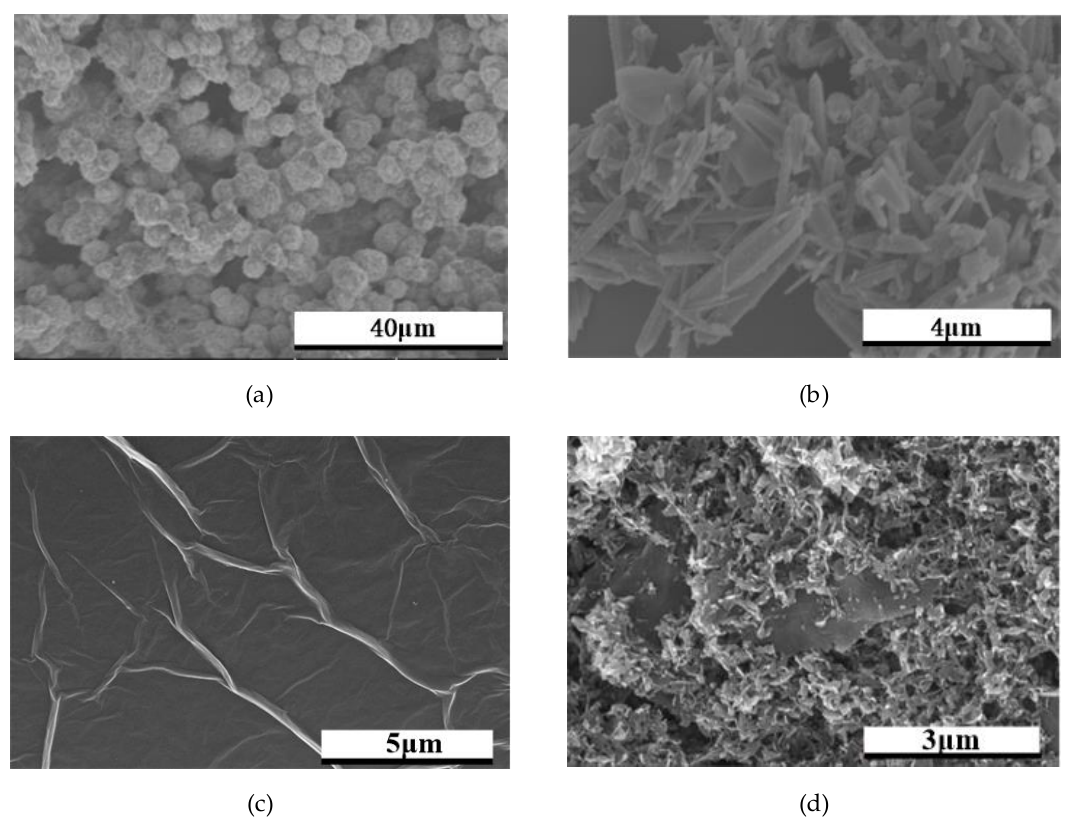
Figure 2. SEM image spectra for ZnO and ZnO composite graphene: ( a ) ZnO microspheres; ( b ) ZnO nanorods; ( c ) ZnO nanosheets; ( d ) flake ZnO composite graphene.